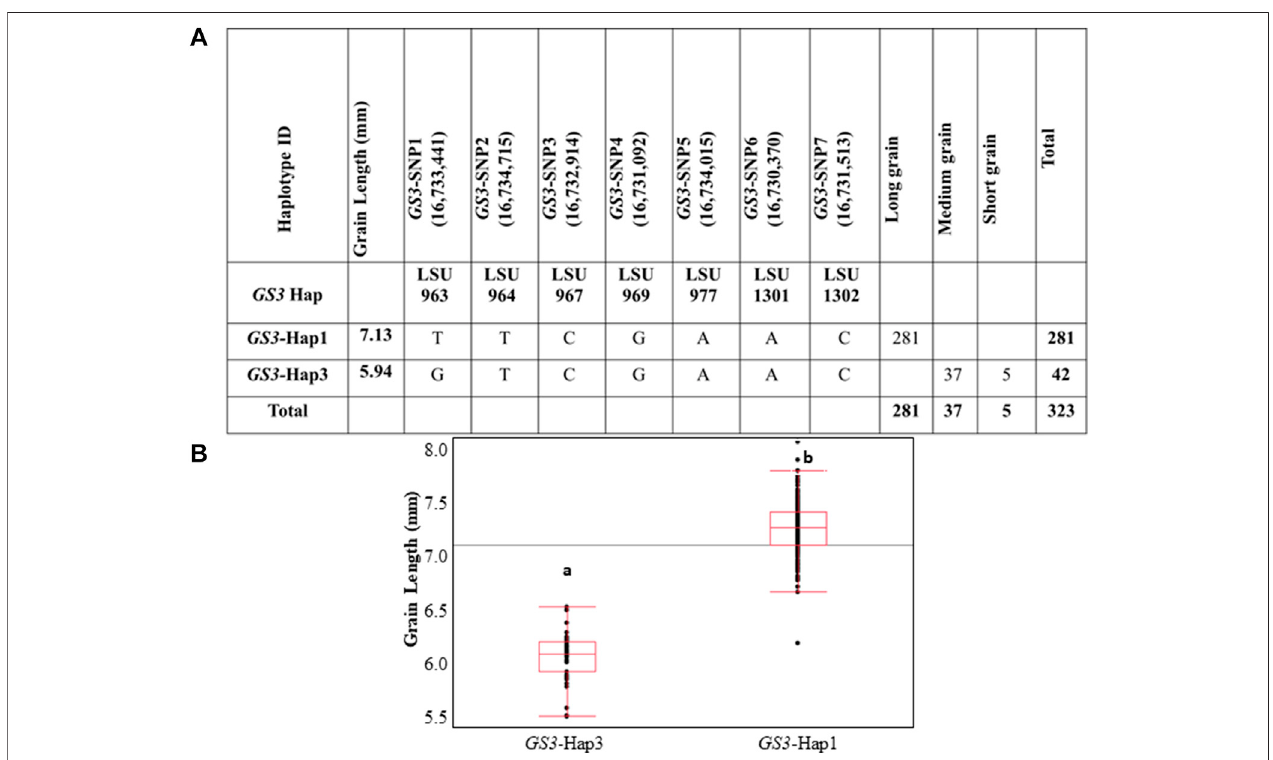
FIGURE2|(A) Haplotypecharacterizationof GS3 inU.S.ricegermplasm.HaplotypesthatwerecharacterizedintheIRRI3KRGPpanelwerescreenedinU.S.rice germplasmpanel based onthe minimumSNP set identi fi edtodifferentiate theeight haplotype groupsin IRRI 3K RGPdataset. (B) Phenotypicassociationofhaplotype/ SNP alleles and grain length across U.S. rice germplasm. Different alphabet letters on each class represent the statistically signi fi cant difference p < 0.001 within each